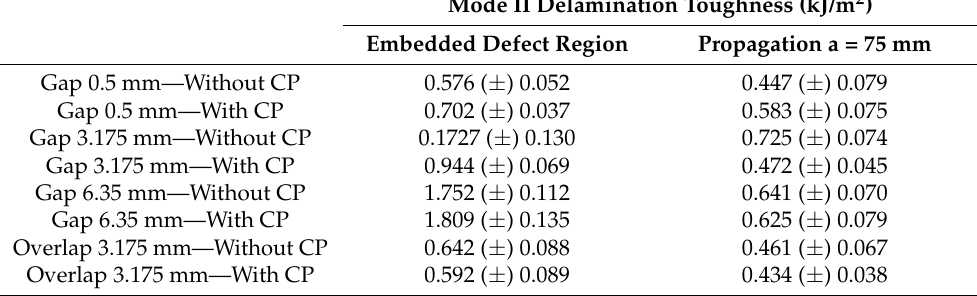
Figure 16. Mode II fracture energy as a function of the crack length for six 4ENF specimens containing an overlap of 3.175 mm from plates manufactured with caul plate. Table 2. Summary of mode II test results. Mean values and standard deviations from tests on 6 specimens for each configuration.